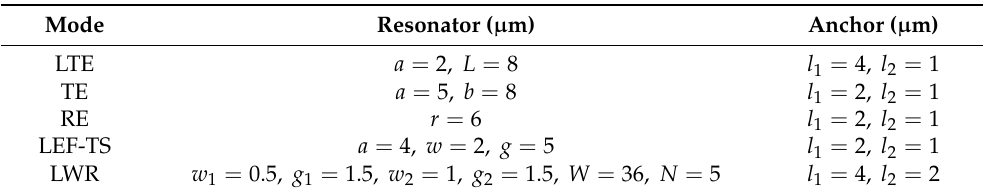
Table 1. The sizes of the resonators used in the simulation, where the symbols correspond to those in Figure 1.